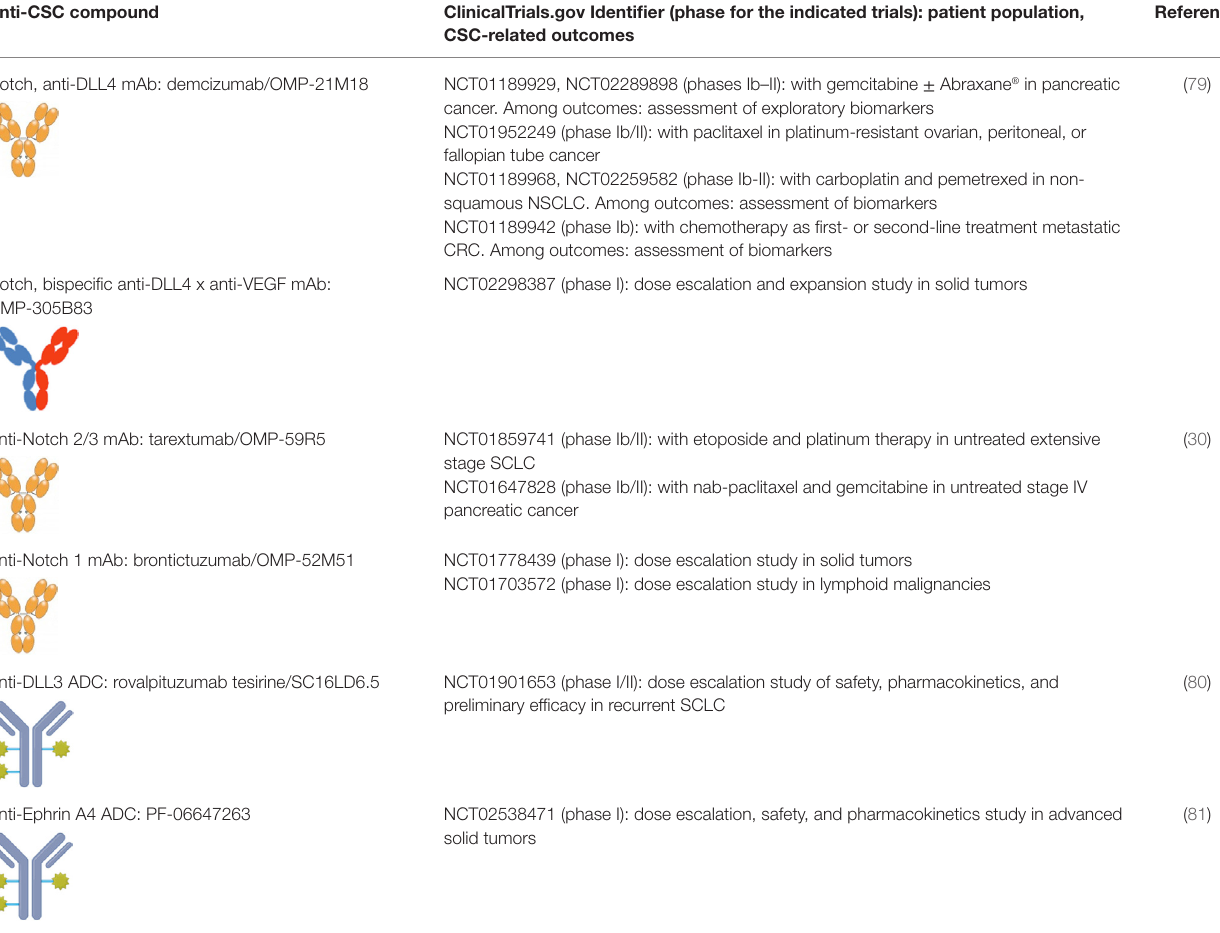
ClinicalTrials.gov identifier (phase for the indicated trials): patient population, CSC-related outcomes